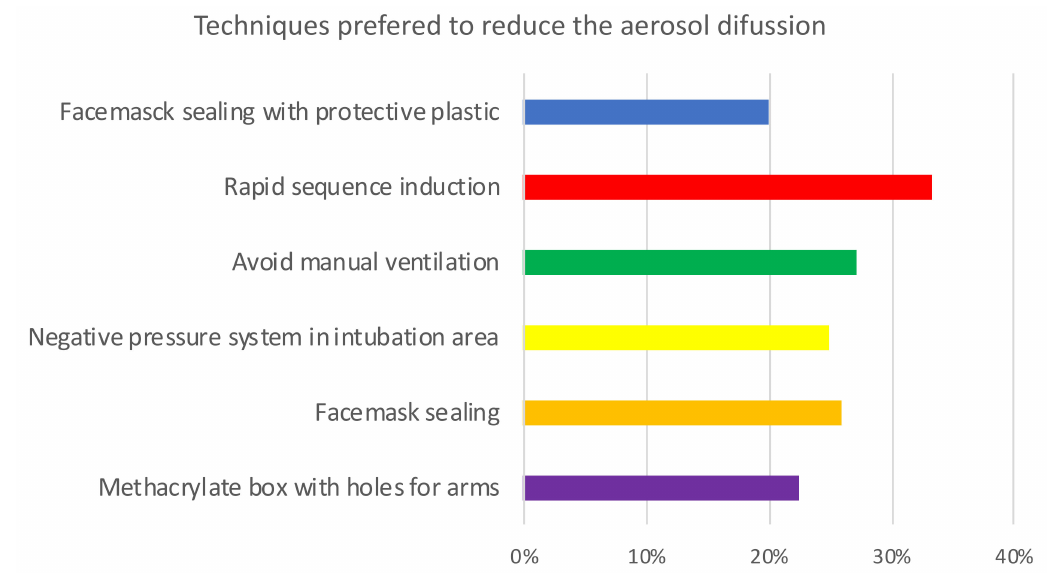
Figure 3. Opinion on the usefulness of techniques to reduce aerosol diffusion during tracheal intubation in COVID-19 patients. 6-point Likert scale (from 1 = strongly disagree to 6 = strongly agree; Percentage scoring 6: n (%).